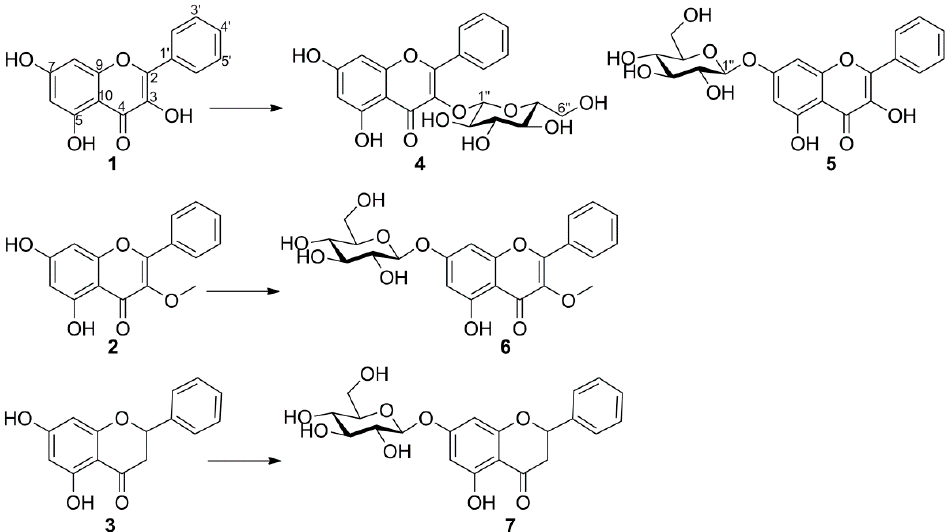
Figure 1. Microbial transformation of compounds 1 – 3 by M. hiemalis .